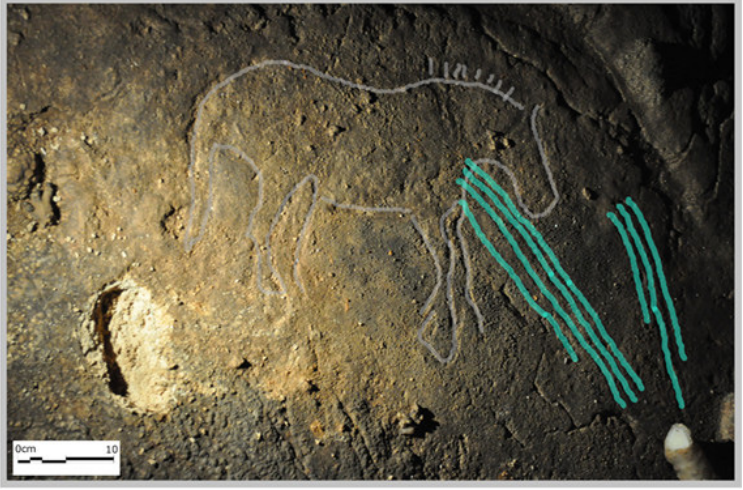
Figure 6. Fluting by an adult intersecting a horse in El